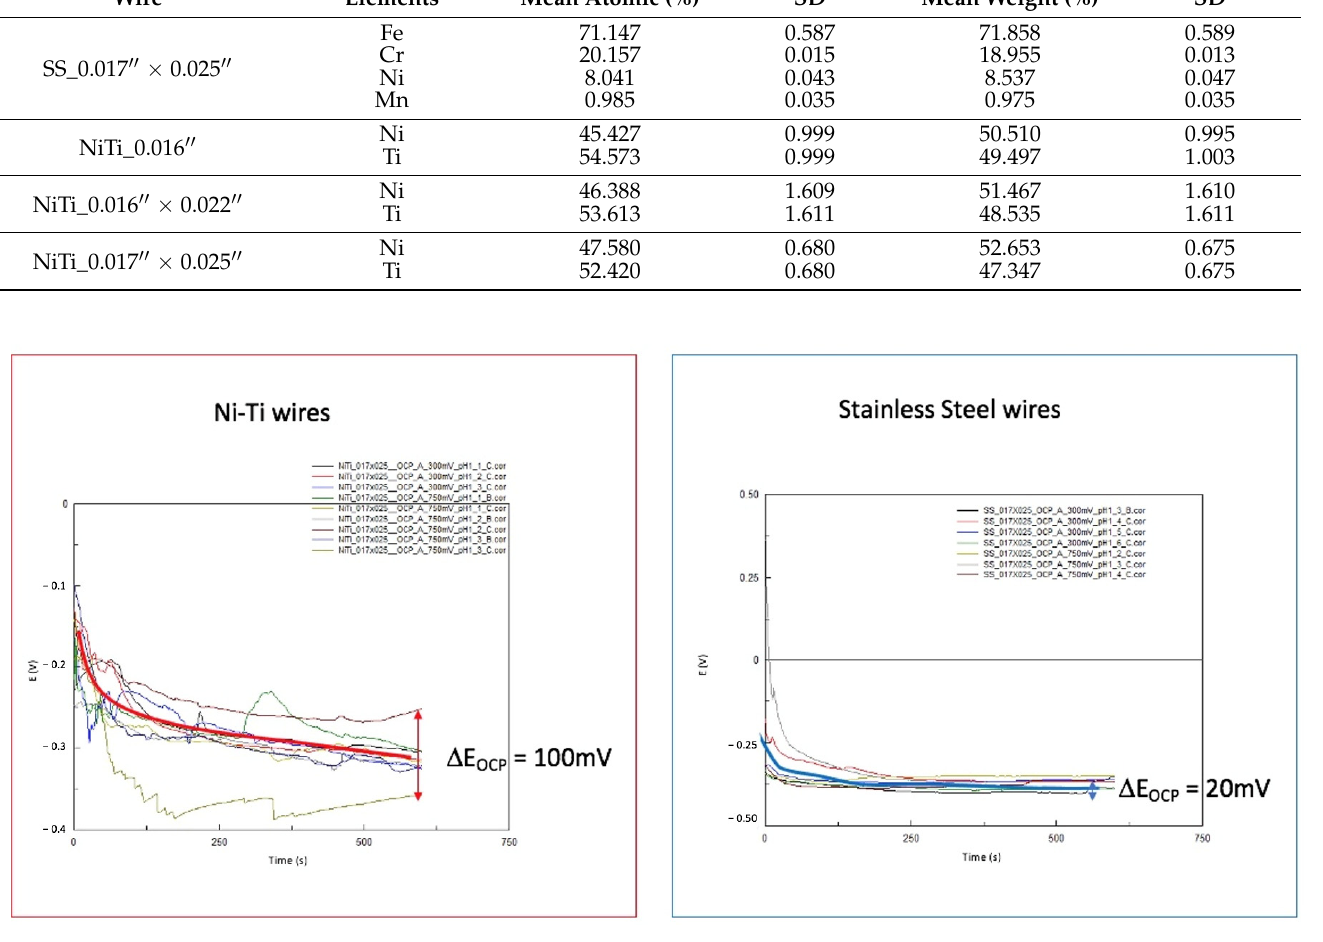
Figure 9. Two CV Log(i) versus E curves from two SS wires in Ringer’s solution pH = 1, RT; the positions for polarization are marked with red arrows.